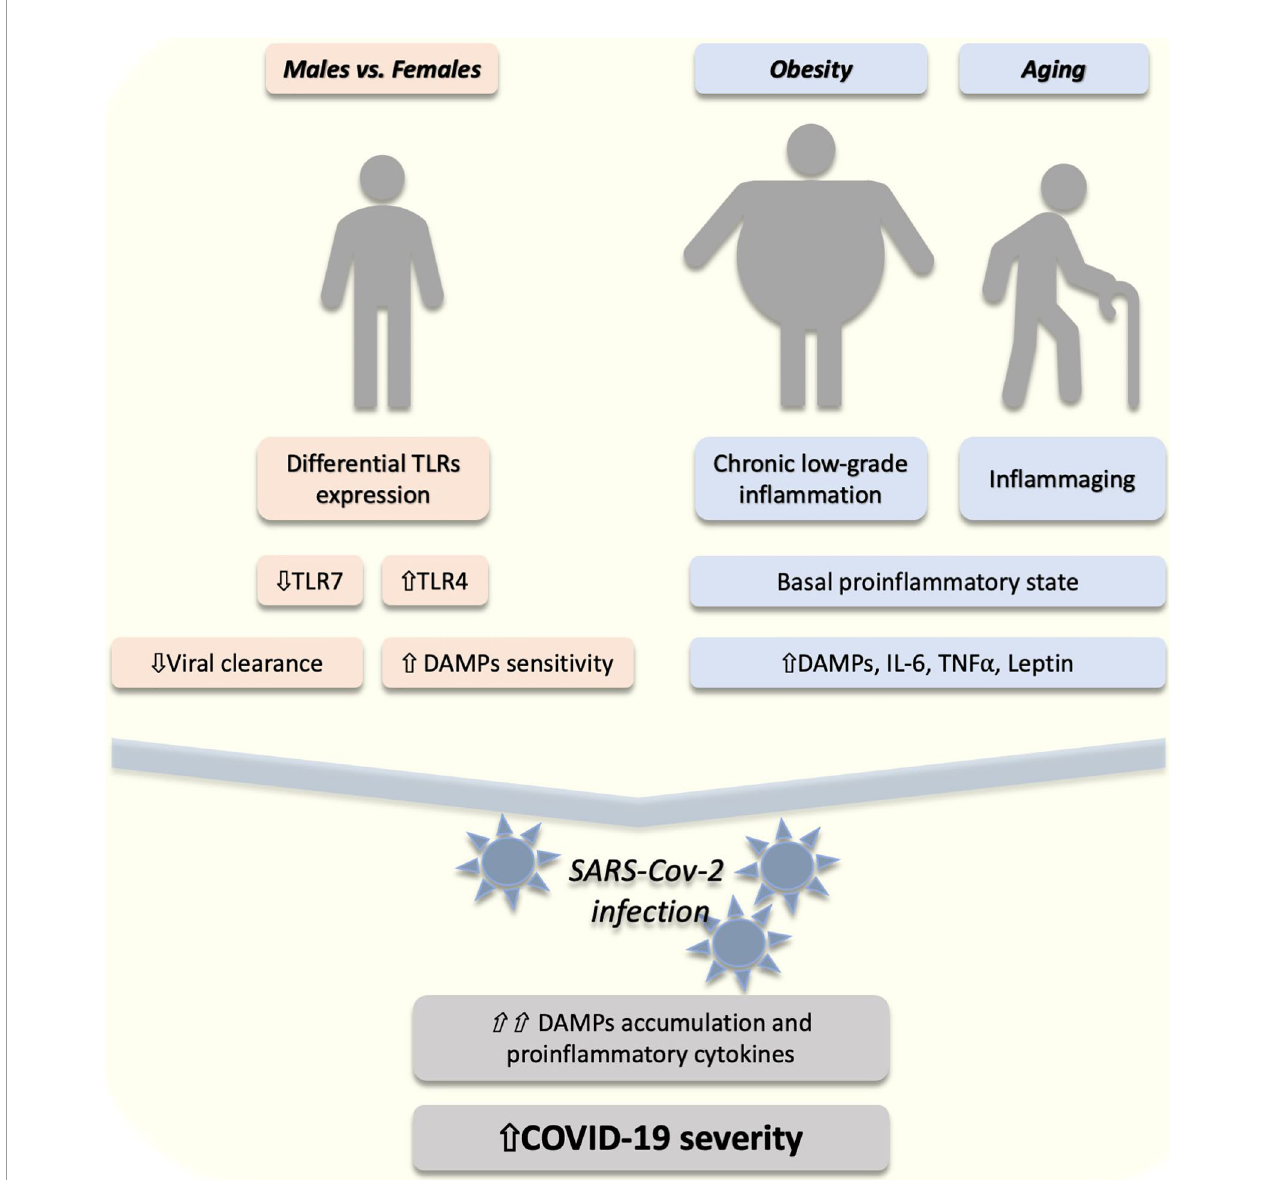
FIGURE 1 | The proposed role of DAMPs/TLRs in the risk factors of COVID-19 severity. In males (compared to females) a lower ( ⇓ ) expression of toll-like receptor (TLR) 7 might ( ⇓ ) reduce the viral clearance. On the other hand, higher ( ⇑ ) TLR4 in males might lead to higher ( ⇑ ) sensitivity to danger-associated molecular patterns (DAMPs). Furthermore, obesity and aging are conditions associated with a proin fl ammatory state characterized by increased ( ⇑ ) DAMPs, interleukin 6 (IL-6), and tumor necrosis factor alpha (TNF a ). After SARS-CoV-2 infection, an exacerbated ( ⇑⇑ ) accumulation of DAMPs and proin fl ammatory cytokines might explain the higher ( ⇑ ) COVID-19 severity in these